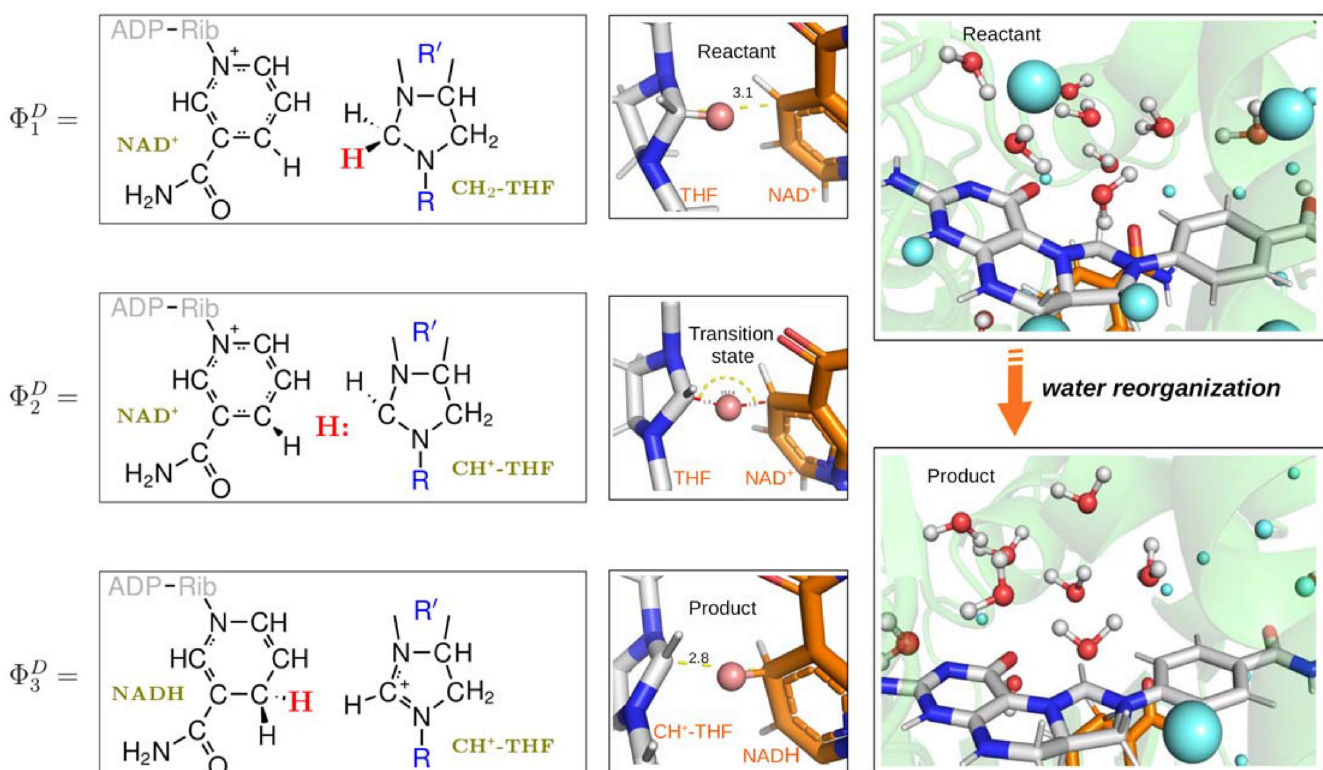
Fig 5. The left column shows the resonance states ( F 1D , F 2D , and F 3D ) used to describe the dehydrogenase activity. The middle column shows snapshots of the reactant, intermediate and product state, which are depicted as stick and colored by elements (C atoms: white for THF and orange for NAD + /NADH). The hydroxide is shown as a sphere and colored in salmon red. In the optimized reactant geometry, the distance between the reactive C atom of CH 2 -THF and the reactive C atom of NAD + is 3.1 Å , with the transferring hydrogen at 2.1 Å from the acceptor C atom. The last column shows snapshots representing the water reorganization from the reactant state to product state. The water molecules within 7 Å from the reactive C atom of THF are shown as both stick and sphere and colored red for oxygen atoms, while for the water molecules beyond 7 Å are only shown as blue spheres to distinguish them.